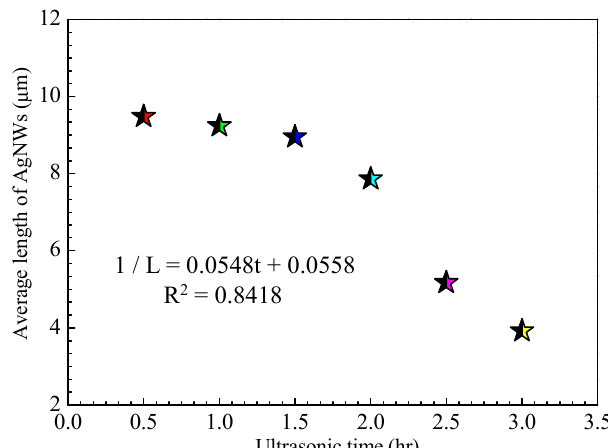
Figure 3. Relationship between the average length of AgNWs and ultrasonic treatment time.